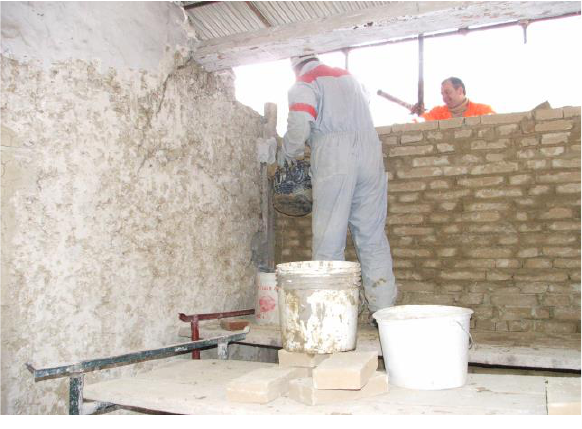
Figure 2. The restoration work.